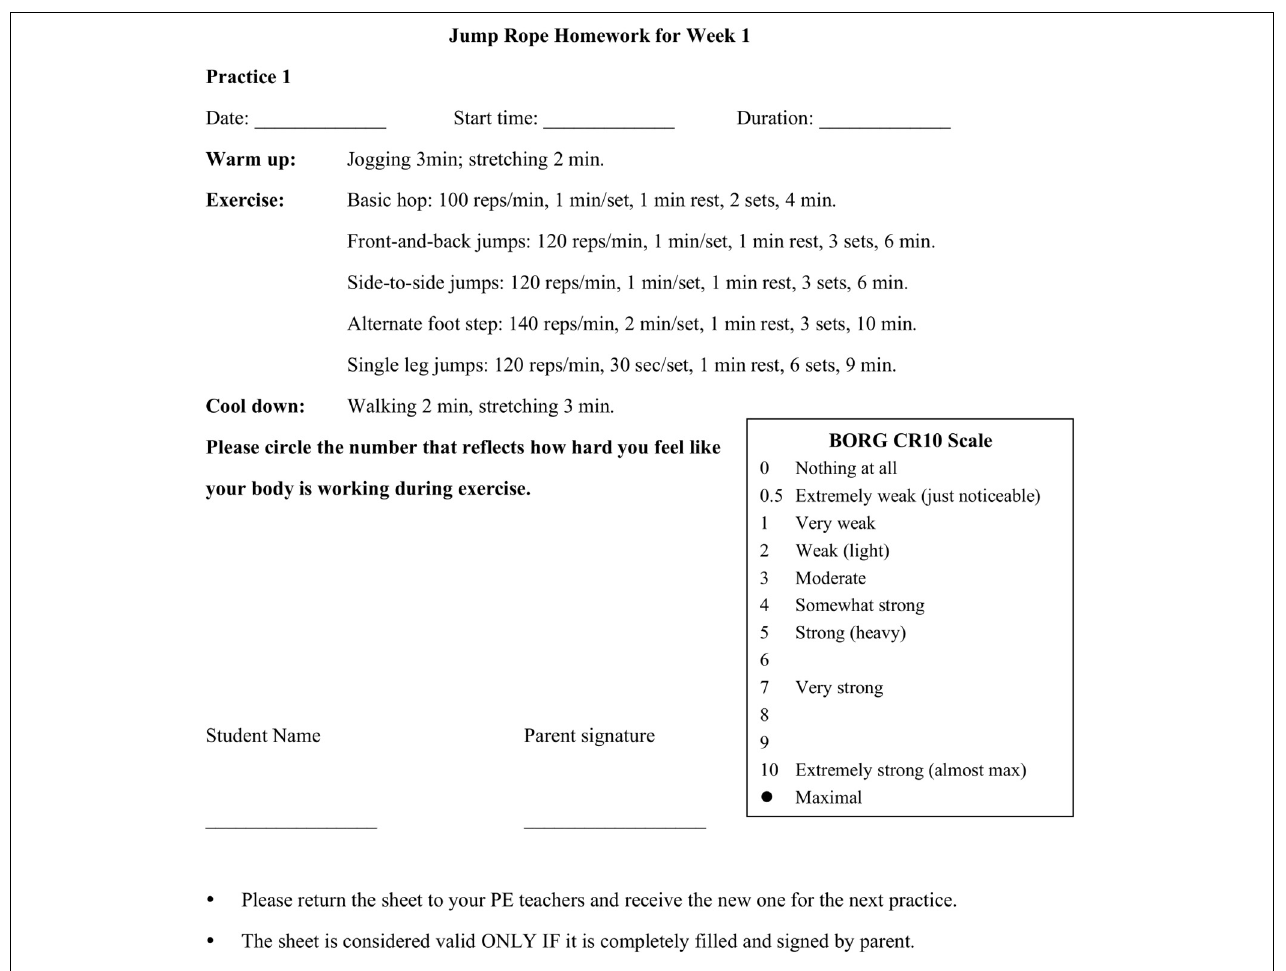
FIGURE 2 | Example of homework sheet for participants in